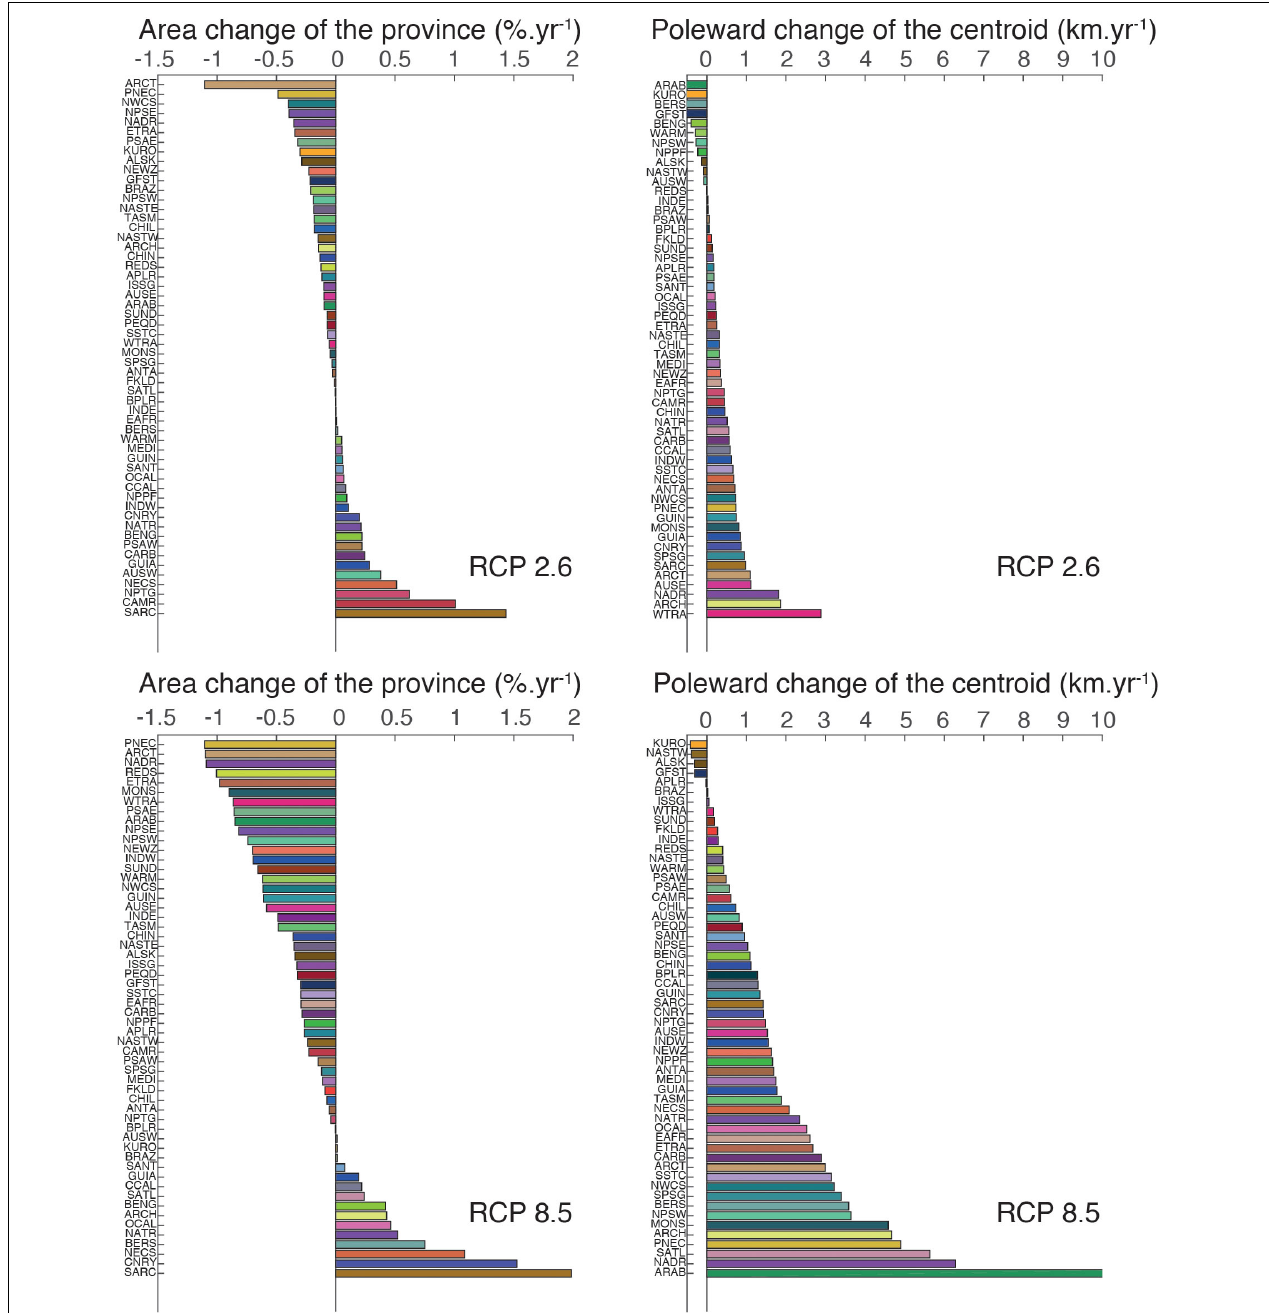
FIGURE 2 | Bar plot of the mean latitudinal change of the BGCPs’ centroid (in km . year − 1 ) and percentage of BGCPs area change by 2100 compared to the 1970–2000 reference period (in % . year − 1 ) under RCP 2.6 and 8.5. The color code as well as acronyms are the same as Figure 1A .